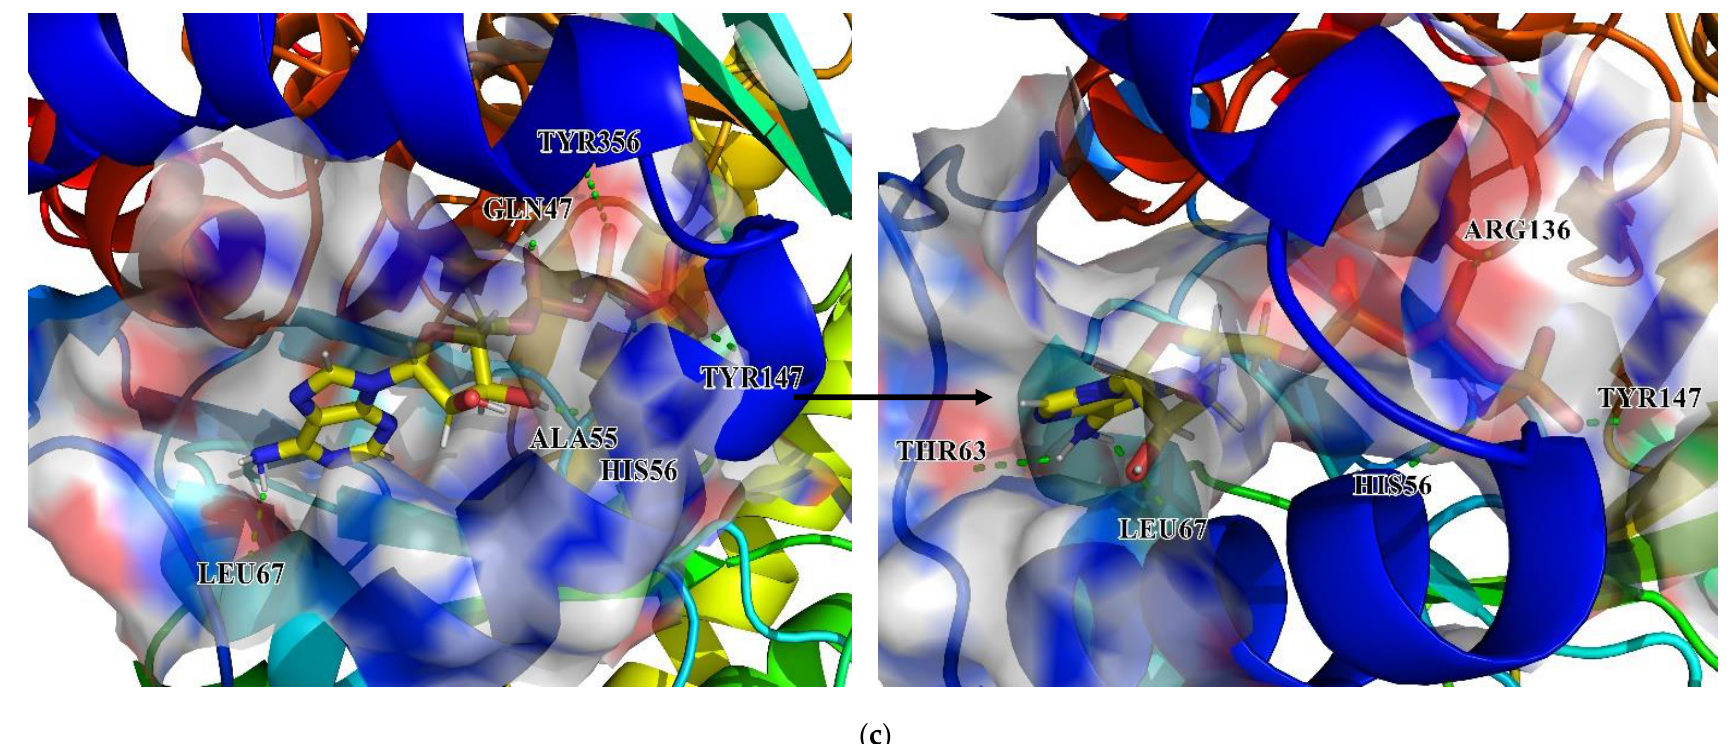
Figure 20. Changes in the initial and final conformations in molecular dynamics simulations. ( a ) DHODH protein with ZINC8577218. ( b ) DHODH protein with ZINC95618747. ( c ) DHODH protein with ZINC4261765.